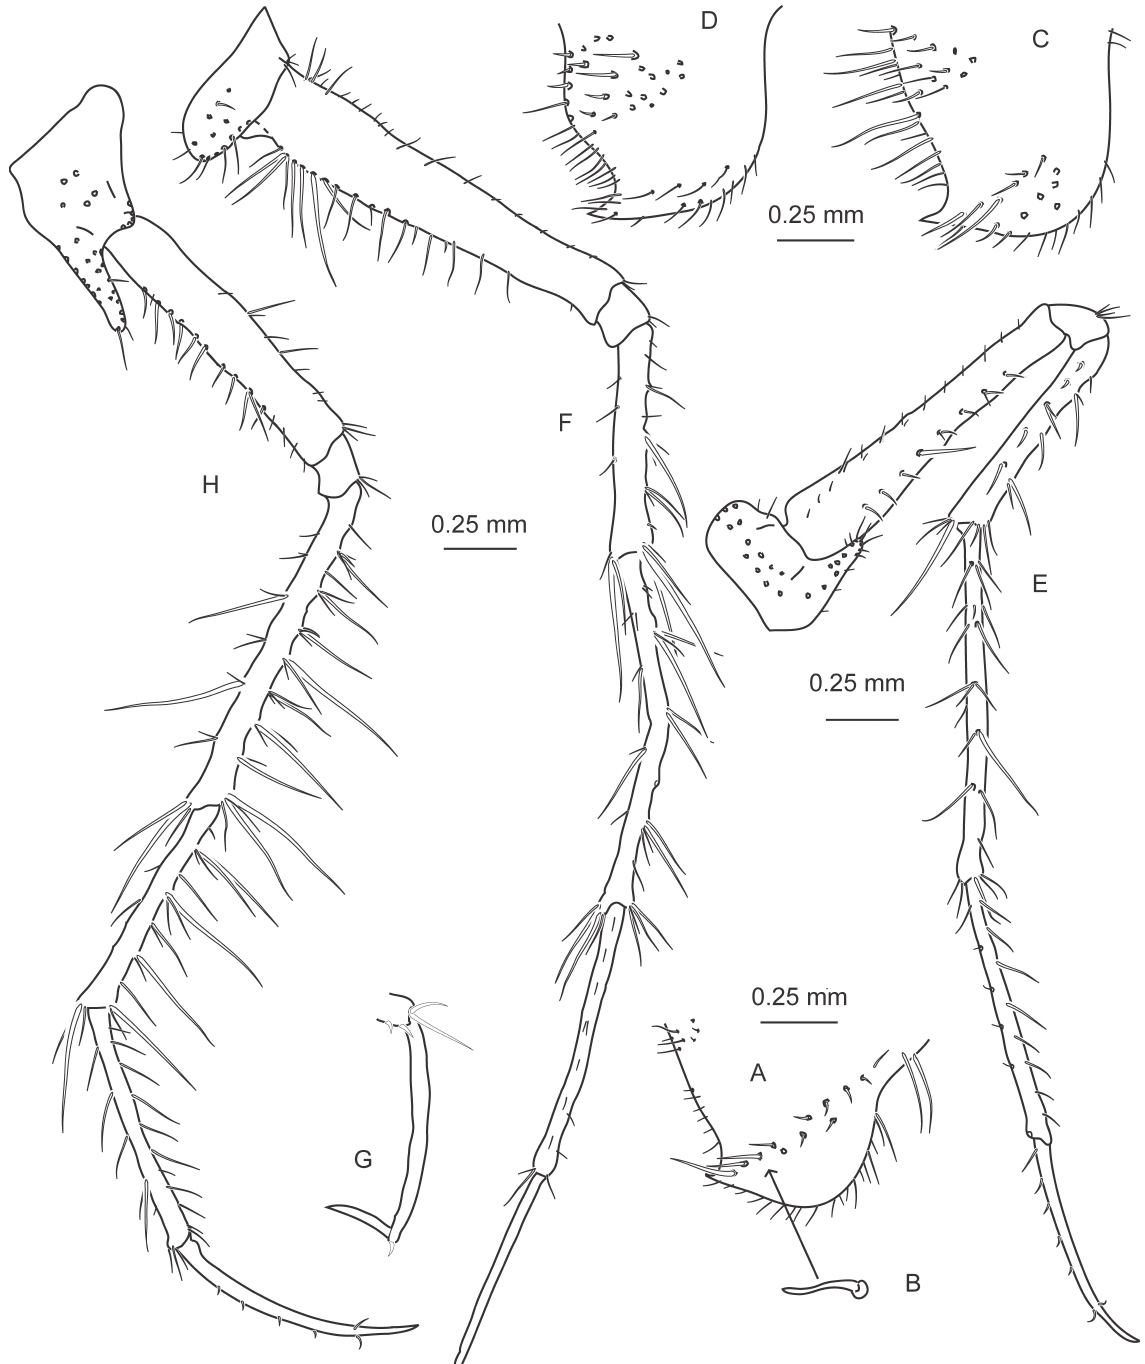
Fig. 6. Lepechinella norvegica sp. nov., holotype, ♂. A . Right Ep1. B . Spine on Ep1. C . Right Ep2. D . Right Ep3. E . Left P5. F . Right P7. G . Dactyl of left P7. H . Left